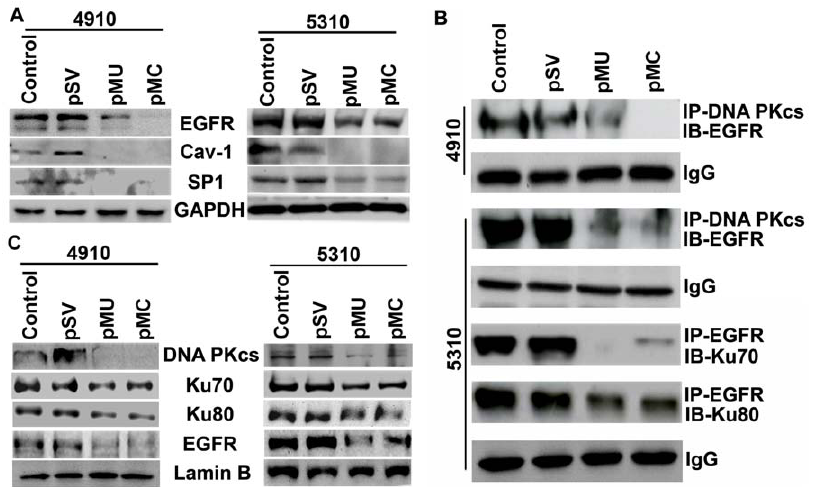
Figure 2. Regulation of DNA PK activity in pMU- and pMC-transfected glioma cells. A. Western blot analysis shows expression of EGFR, cav-1 and SP1 in pMU- and pMC-treated glioma cells along with control and pSV. B. Immunoprecipitation (IP) analysis. IP of DNA PKcs was immunoprobed with EGFR in both 4910 and 5310 glioma xenograft cells transfected with pMU and pMC along with control and pSV samples. IP of EGFR was immunoprobed with Ku70 and Ku80 in pMU and pMC treated glioma cells. IgG shows equal loading. C. Immunoblot analysis of DNA PKcs, Ku70, Ku80 and EGFR from nuclear lysates was carried out in pMU and pMC silenced 4910 and 5310 glioma xenograft cells. Lamin B was used for equal loading. Each experiment was repeated 3